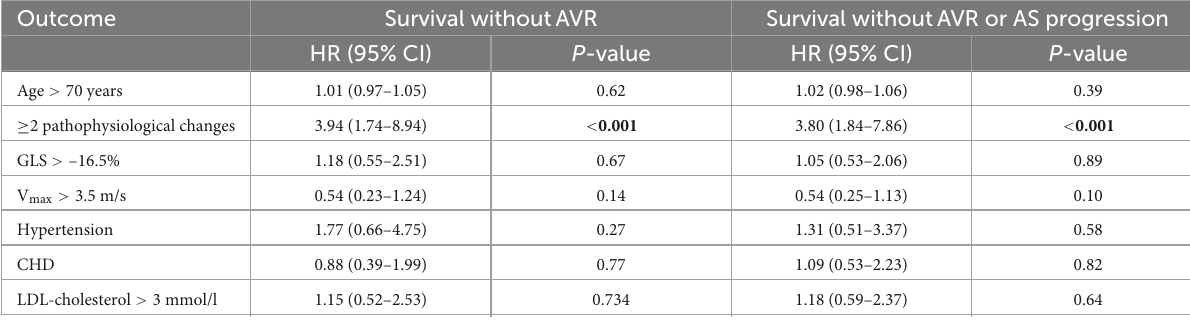
TABLE 4 Multivariate analysis of potential predictors of outcome in moderate aortic stenosis (AS).